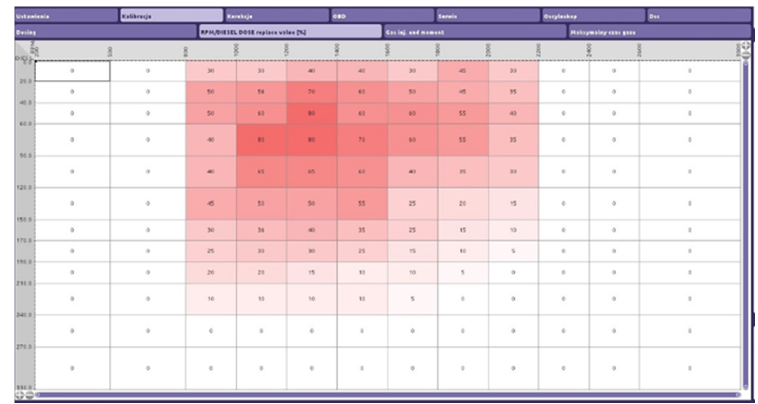
Figure 13. T Map of Diesel/CNG replacement